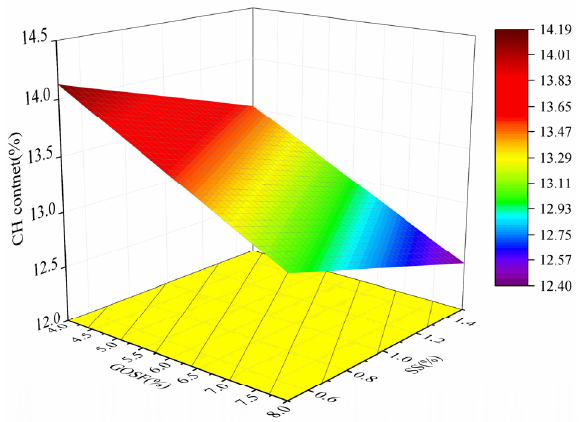
Figure 15. The CH content of samples vs. the dosages of GOSF and SS.